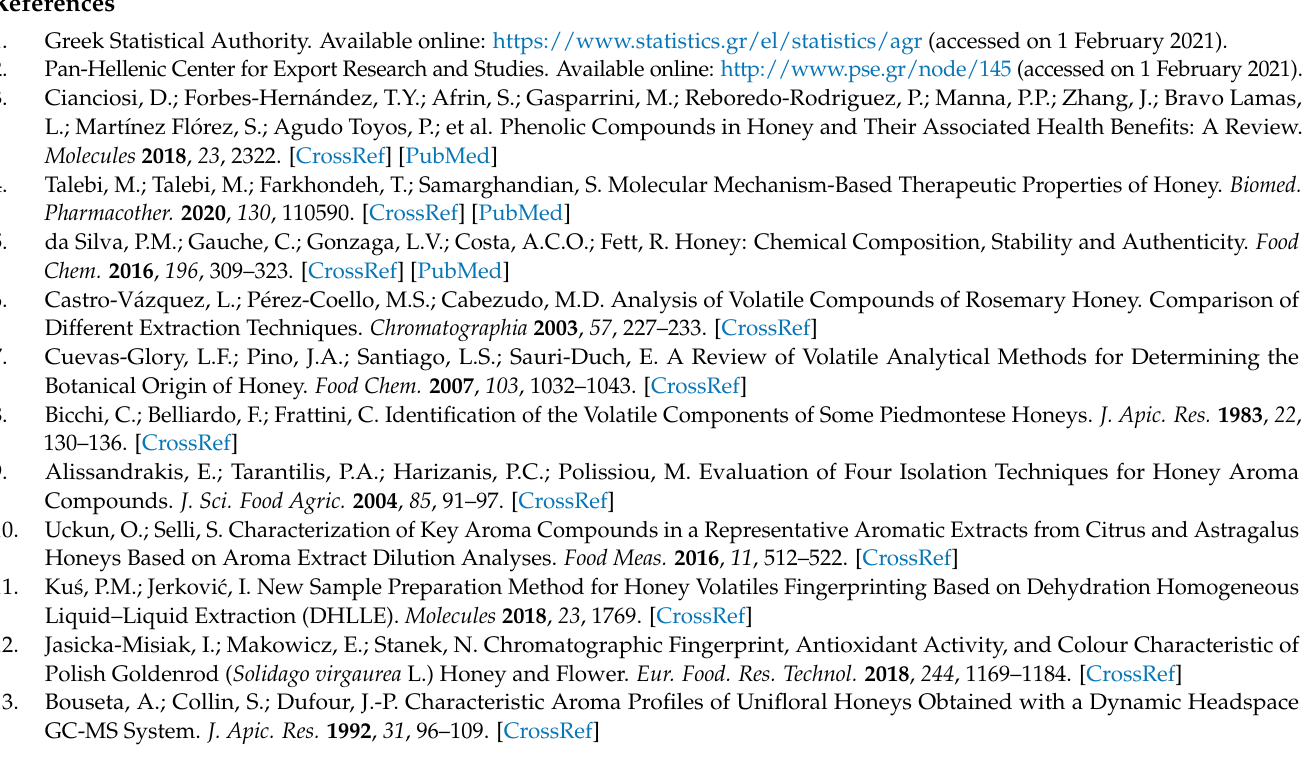
Supplementary Materials: The following are available online. Figure S1: Box-cox plot of benzalde- hyde. Figure S2: Box-cox plot of 2-phenylacetaldehyde. Figure S3: Box-cox plot of undecane. Figure S4: Box-cox plot of nonanal. Figure S5: Box-cox plot of 2-phenylethan-1-ol. Figure S6: Box-cox plot of 2-phenylacetonitrile. Figure S7: Box-cox plot of 1-phenylbutane-2.3dione. Figure S8: Box-cox plot of methyl nonanoate. Figure S9: Box-cox plot of 3-hydroxy-4-phenyl-2-butanone. Figure S10: Box-cox plot of ( Z )-3-hydroxy-4-phenylbut-3-en-2-one. Figure S11. A characteristic chromatograph from blank sample. Table S1: Volatile compounds isolated from the headspace of thyme honey samples used for validation test. Table S2: Design layout